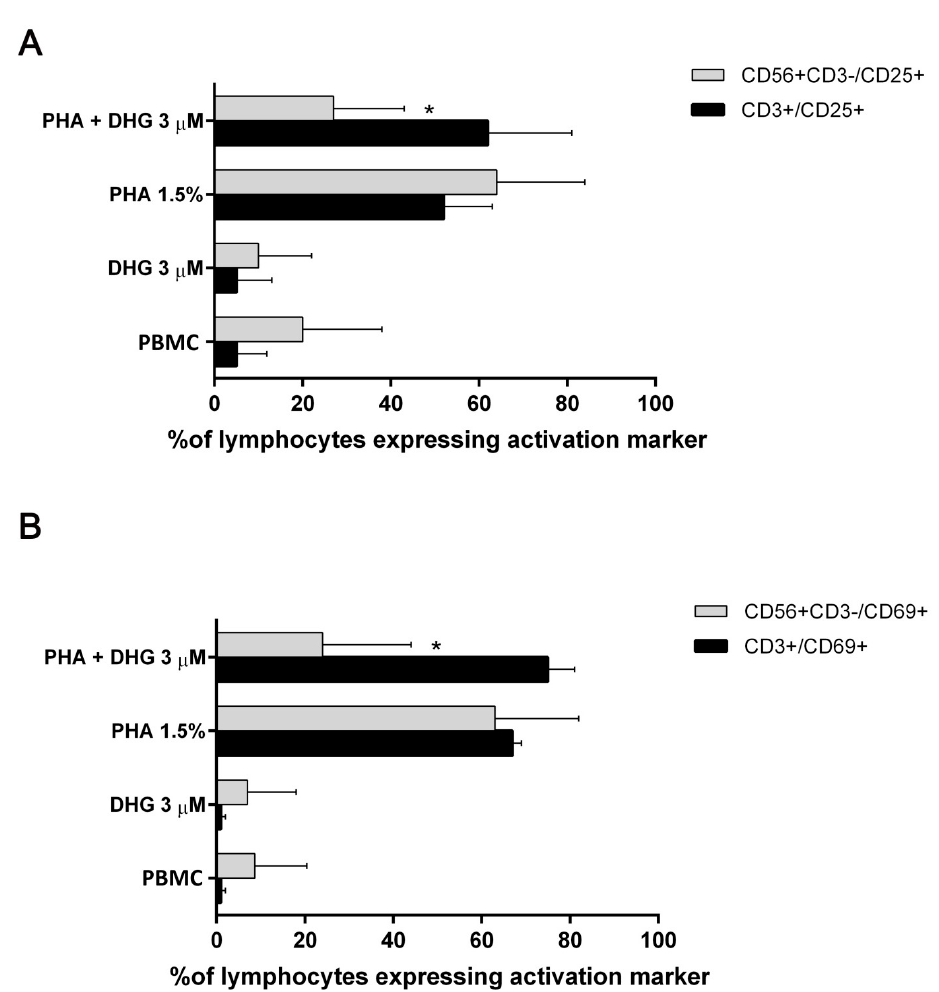
Figure 4. Flow cytometric analysis of CD25 and CD69 surface expression on DHG-treated PBMC. PBMC from healthy donors ( n = 7) were stimulated with PHA (1.5%) in the presence and in the absence of DHG. Unstimulated cells are included as control (PBMC) in the figure. Following 24 h of activation, CD3+/CD56 − ( black bars ) and CD3 − /CD56+ ( gray bars ) populations were analyzed for CD25+ expression ( A ) and CD69+ expression ( B ) and compared by ANOVA (* p < 0.05, compared with untreated PHA-activated cells). Bar graphs report mean values ± SD.